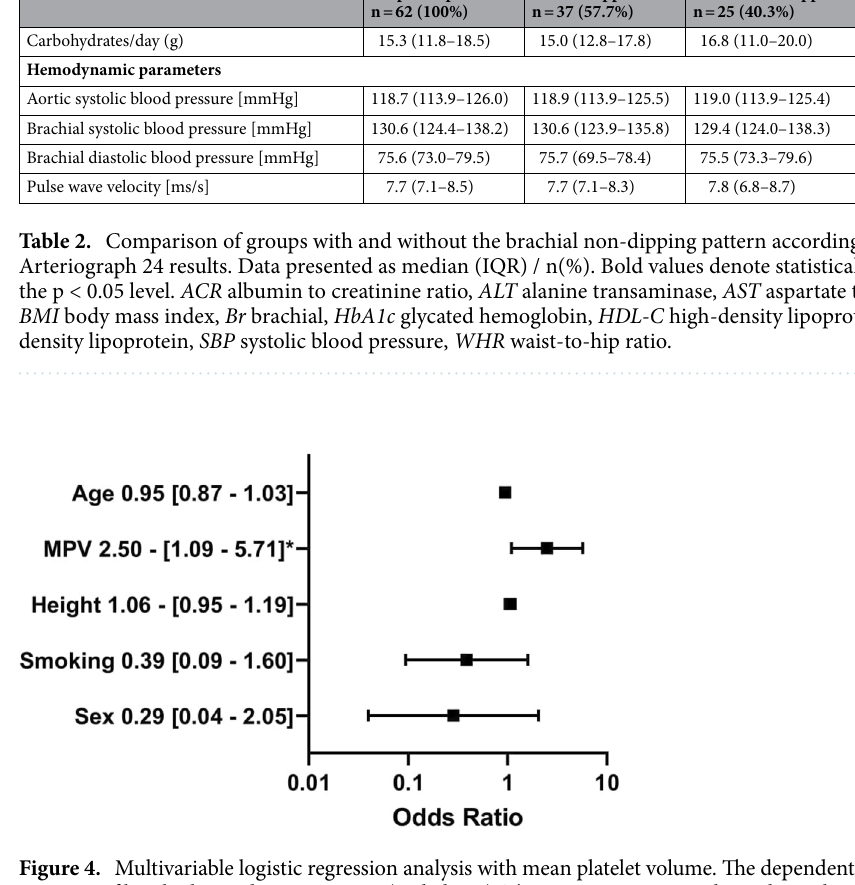
Figure 4. Multivariable logistic regression analysis with mean platelet volume. The dependent variable: the presence of brachial non-dipping pattern (coded one). The outcomes presented as a dependent variable (odds ratio, 95% confidence interval). *. significant at the 0.05 level; **significant at the 0.01 level; MPV mean platelet volume, DDI daily insulin intake. All figures made by authors of the manuscript. GraphPad Prism 9 (https:// www. graph pad. com/) was used to create forest